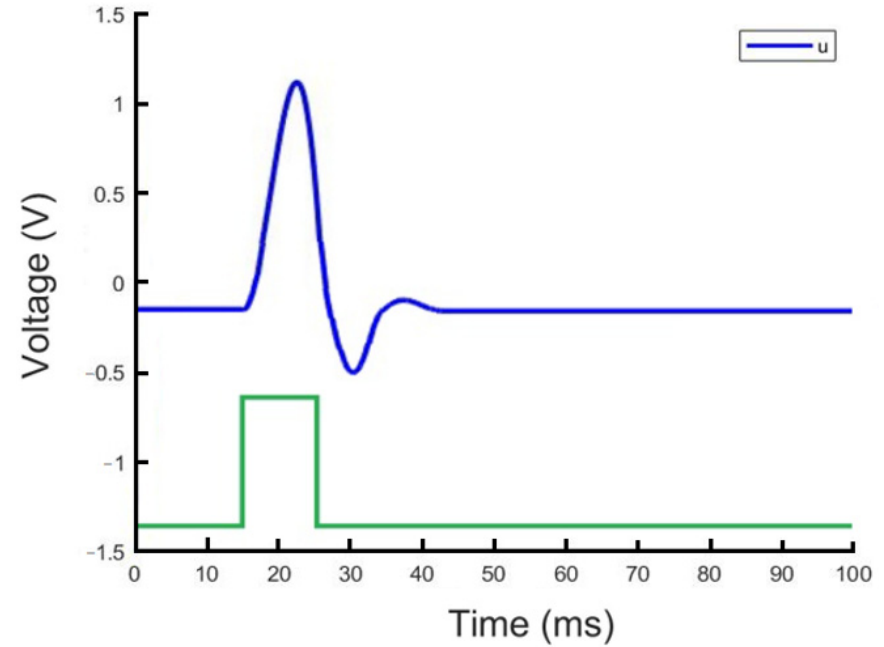
Figure 6. Response of the memristive FHN model on sufficiently strong perturbation current added to the first equation of system (4). The lower panel shows the shape of the current pulse, amplitude—4.42 B, duration—11 ms. Parameter values: η = 0.48, ε = 0.94.